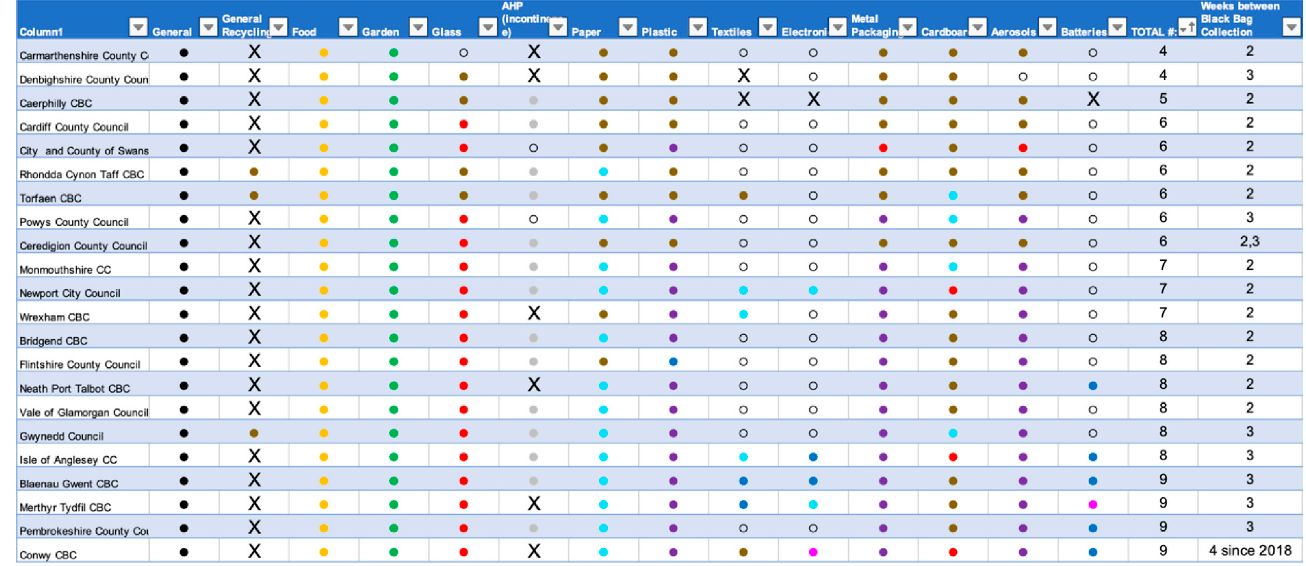
Figure A1. Each coloured spot relates to a new separate collection, if two categories have the same Figure A1. Variation in Collection Methods for Each Welsh Local Authority (LA). Source: Each colour spot they are collected together. Black circles indicate that items can be recycled separately LA within the LA but not at the kerbside.